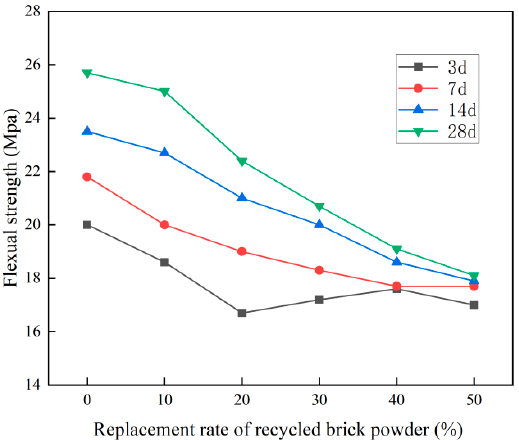
Figure 9. The flexural strength of the recycled micropowder UHPC with different substitution rates. Table 5. The effects of the replacement ratio of regenerated micropowder on flexural strength. Replacement Rate